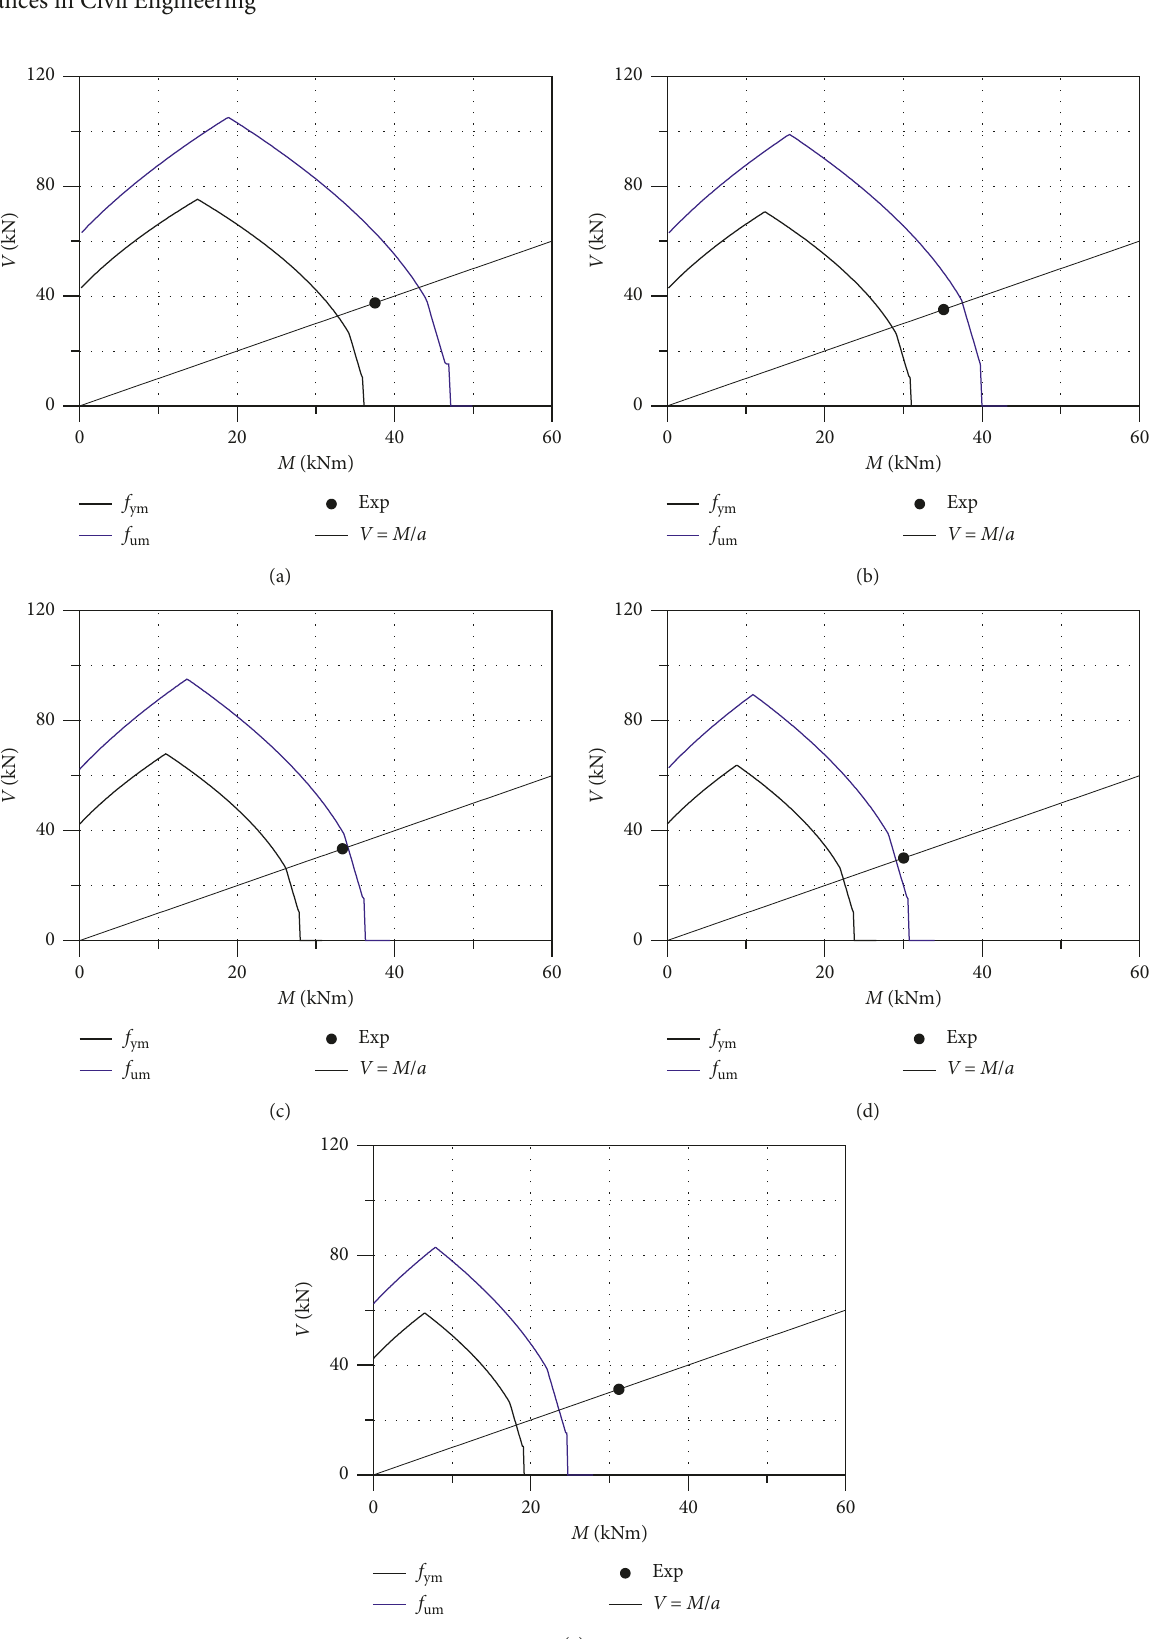
Figure 4: Interaction diagrams M - V for CN specimens tested by El Maaddawy et al. [7]. (a) Virgin, (b) CN-50, (c) CN-110, (d) CN-210, and (e)